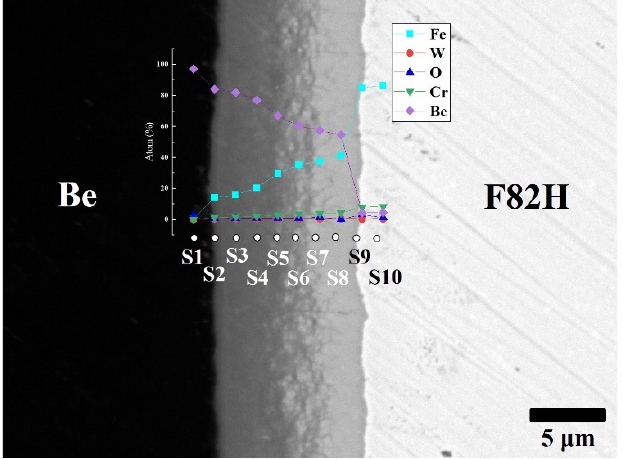
Figure 3. Cross-sectional SEM image of F82H–Be joints sintered at 1023 K for 60 min with point analyses from S1 to S10 with atomic % of Fe, W, O, Cr and Be. Table 1. Chemical composition (at.%) of each point and estimated compounds. Composition (at.%) Measuring Point